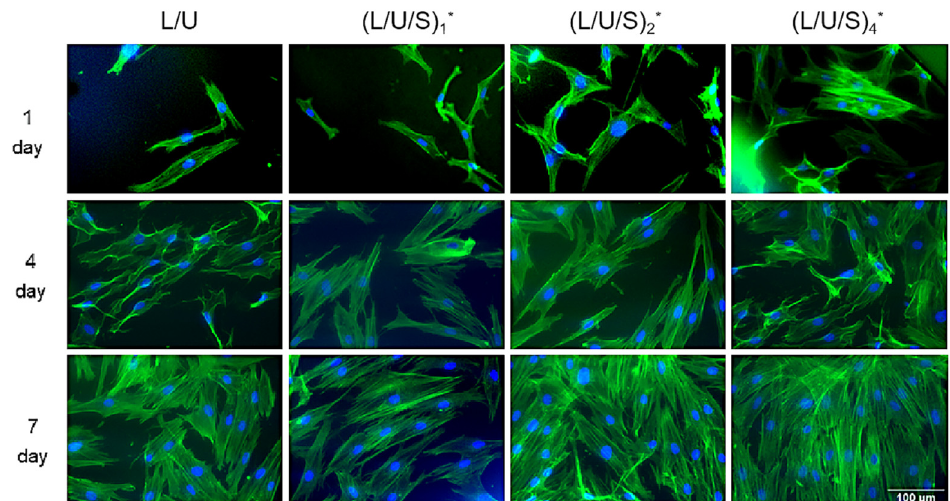
Figure 7. CCK-8 determined cell viability in four groups of electrospun membranes at 1 day ( a ), 4 days ( b ), and 7 days ( c ), and cell proliferation response OD value ( d ). (L/U/S) 1* , (L/U/S) 2* , (L/U/S) 4* referred to the sample after (L/U/S) 1 , (L/U/S) 2 , (L/U/S) 4 were cross-linked, respectively. * p < 0.05, ** p < 0.01.